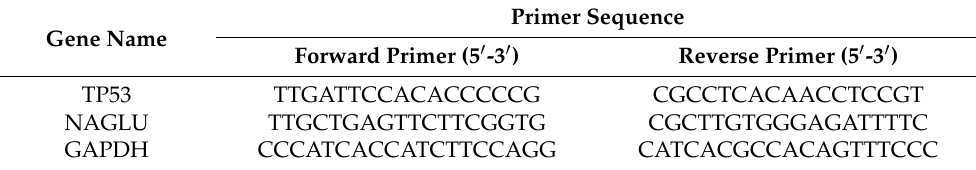
Table 1. The sequences of